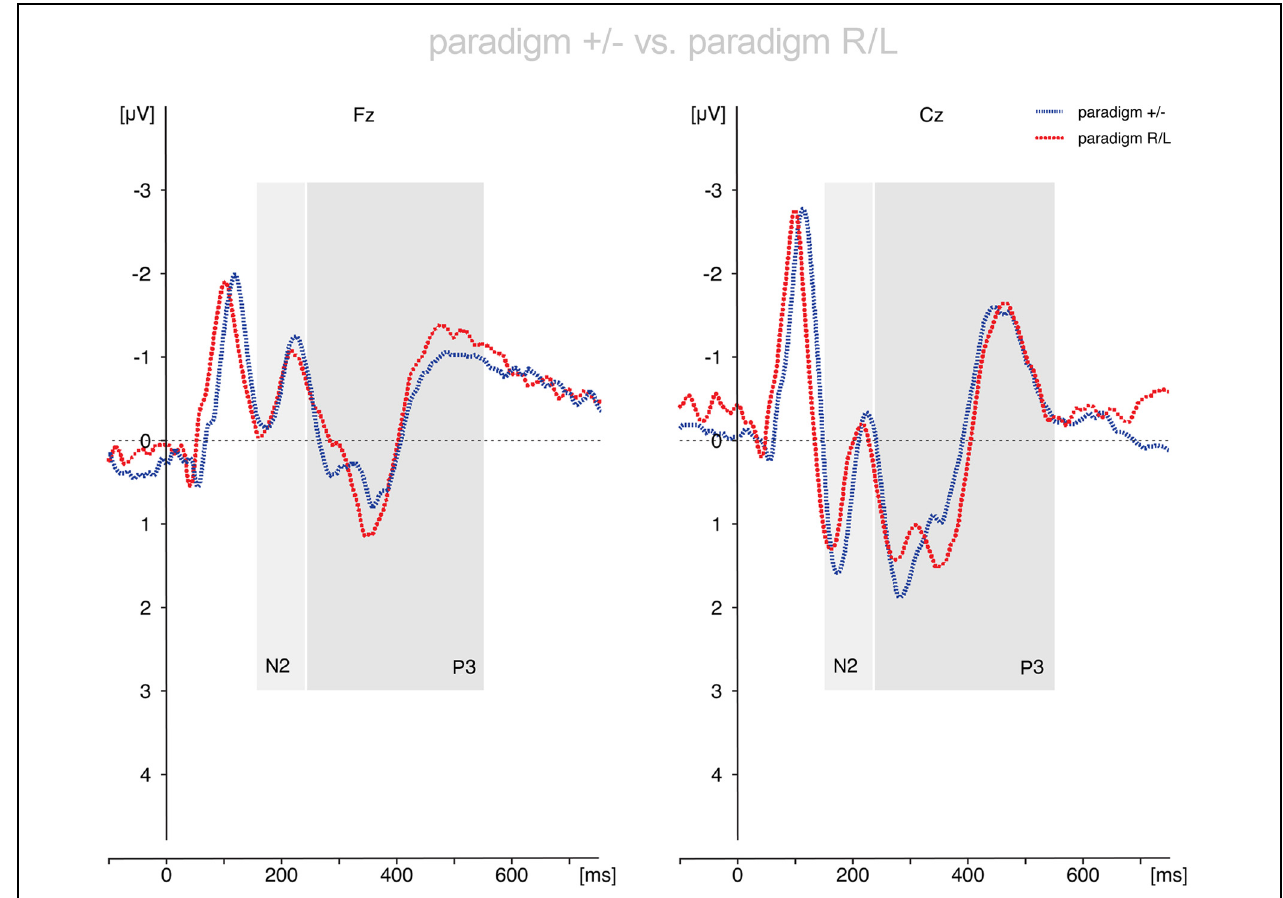
FIGURE 3 | Comparison of the voluntary selection -related responses during paradigm + / − and paradigm R/L. The ERP results differed only marginally between paradigms. Abbreviations µ V, microvolt; ms,